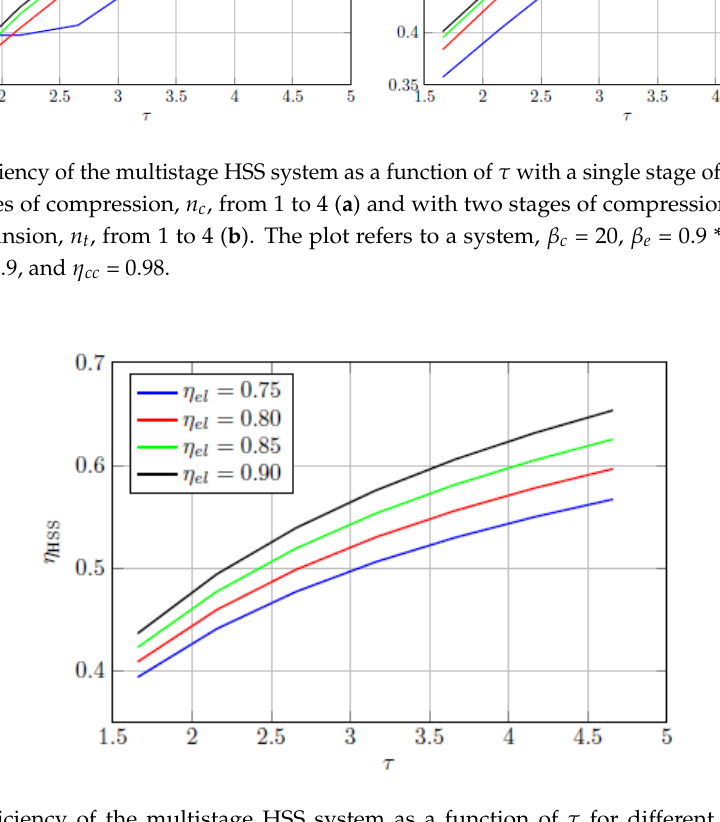
Figure 8. Efficiency of the multistage HSS system as a function of τ for different values of the electrolyzer efficiency from 0.7 to 0.9. The plot refers to a system with three stages of compression and three stages of expansion, β c = 20, β e = 0.9 * β c , η el = 0.80, η t = 0.9, η c = 0.9, and η cc = 0.98.